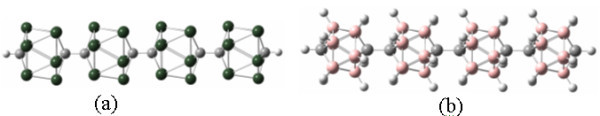
Comparison of silicon-carbon and boron carbon nanorods. (a) Si-C and (b) B-C nanorods.